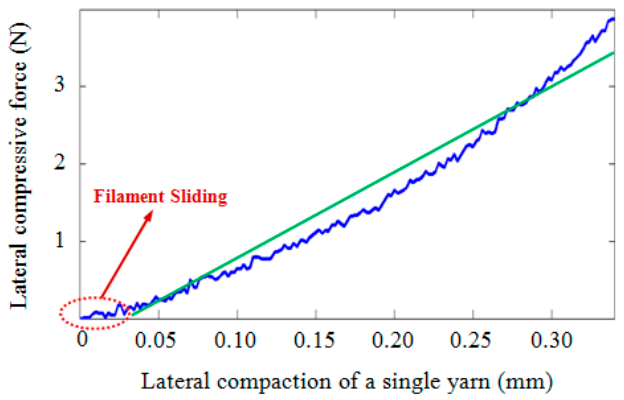
Figure 14. The force-displacement curve for a single yarn under compression in the width direction.